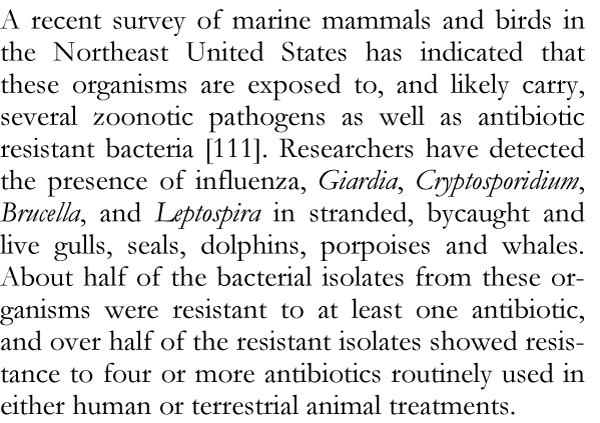
Marine animal zoonoses. Reference [111].